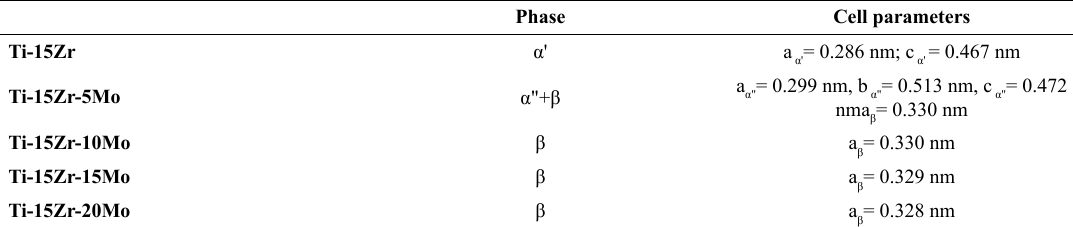
Table 1. Crystalline structure of Ti-15Zr-Mo system alloys obtained by XRD (10).